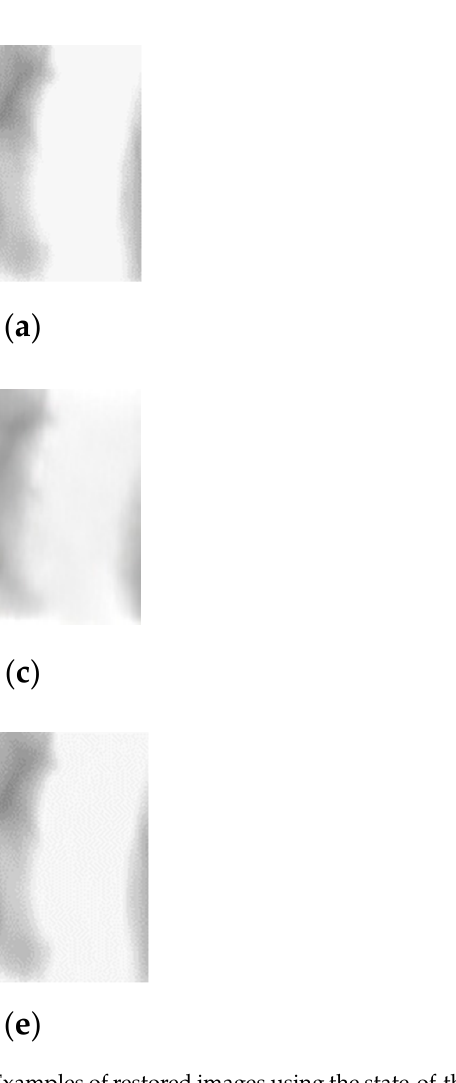
5.270 Table 12. Comparisons of finger-vein recognition error (EER) by using the state-of-the-art restora- tion models and proposed methods with PolyU-DB (unit: %). Original DeblurGAN